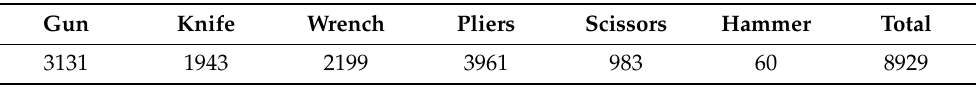
Table 2. Class distribution of positive samples in SIXray dataset. As class “hammer” contains only 60 sample images, we deprecate it in later